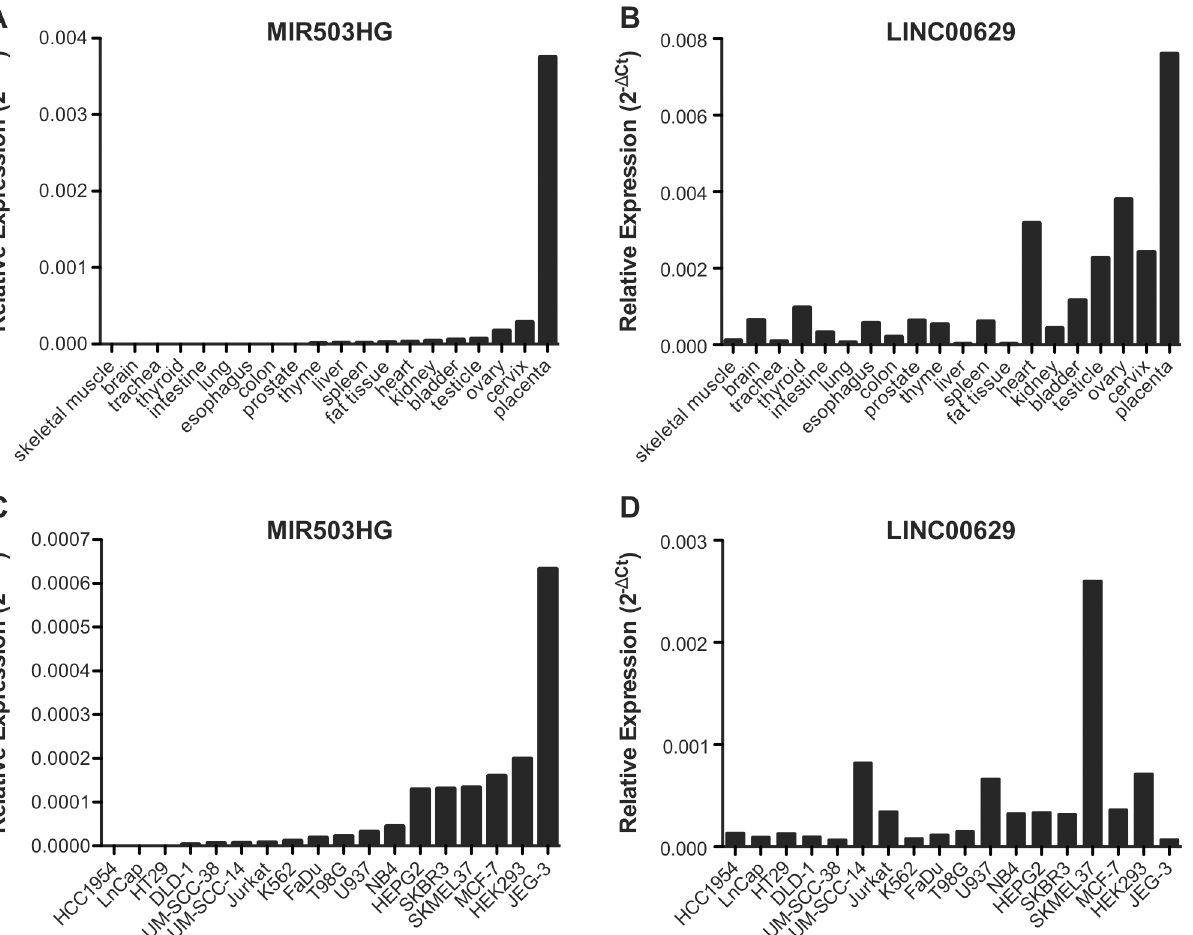
Fig 1. MIR503GH and LINC00629 are highly expressed in placenta and also expressed in other reproductive tissues. A and B. MIR503GH and LINC00629 expressions were determined using RNA samples from a commercial normal human tissue panel, and C and D. Expressions were determined using RNA samples from tumor cell lines. RT-qPCR evaluated the RNA expressions and further normalized by geometric mean from the endogenous genes GAPDH and